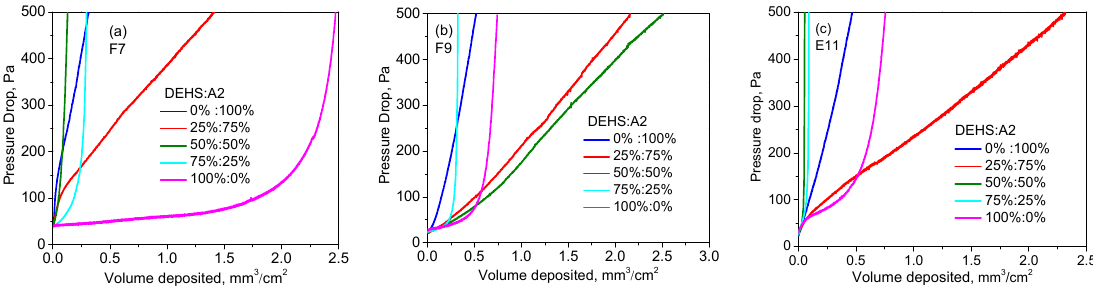
Figure 6. The loading behavior of the ( a ) F7 cellulose, ( b ) F9 melt-blown, and ( c ) E11 membrane- coated filters loaded with different oil-coated particles.